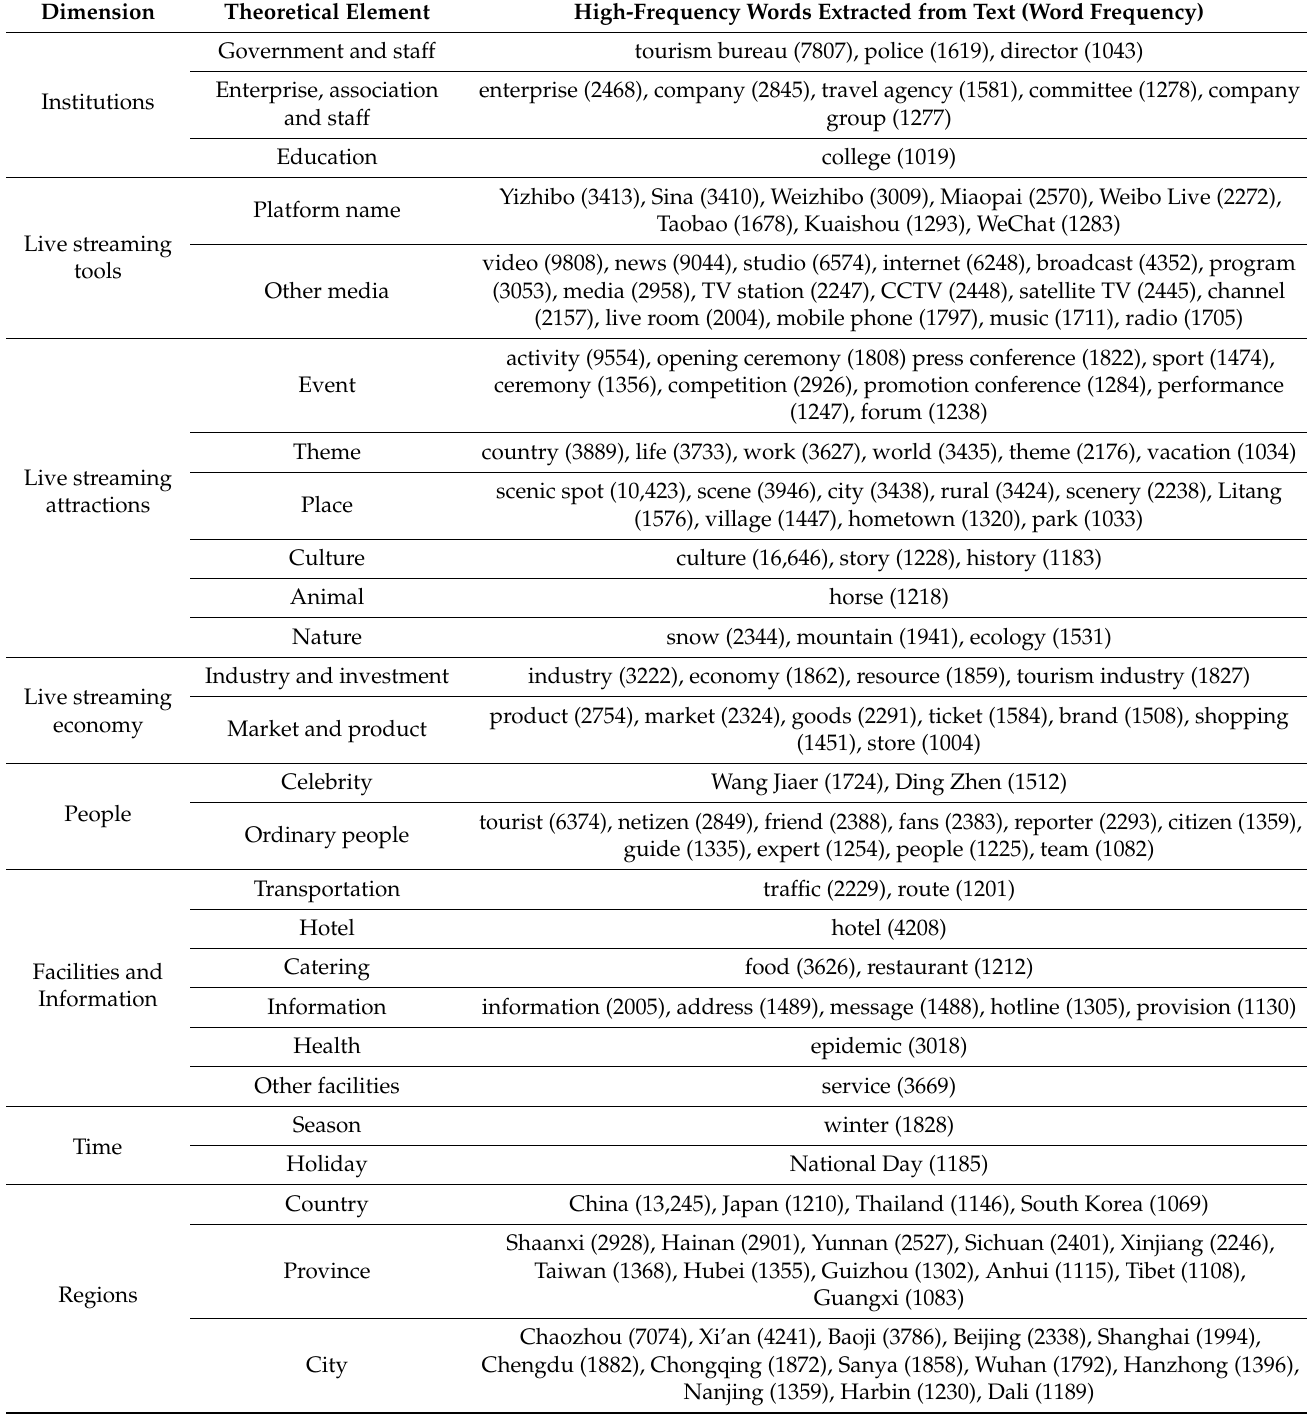
Table 1. High-frequency words, theoretical elements, and dimensions conveying attributes of tourism live streaming.